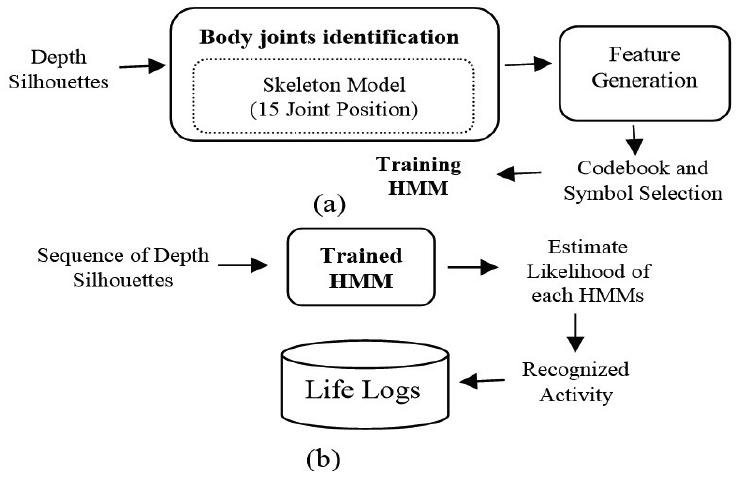
Figure 1. An overview of proposed life logging HAR